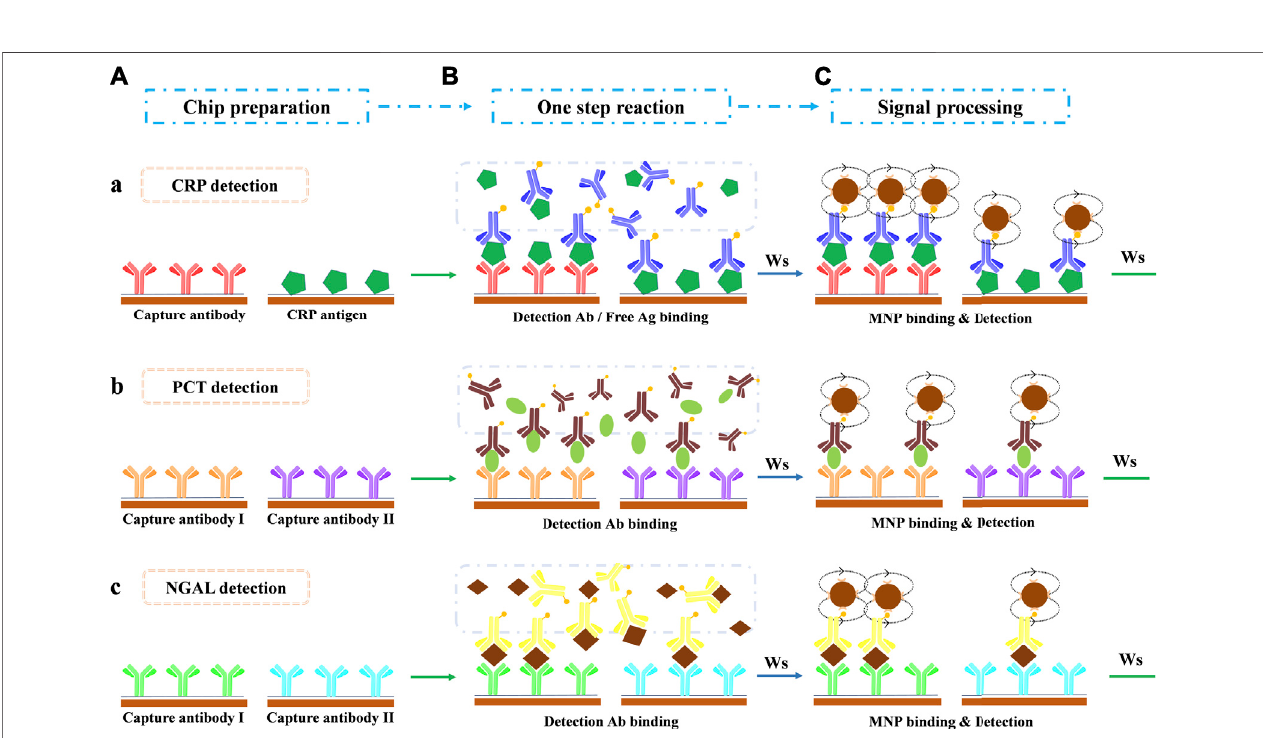
FIGURE2| Assayprotocolformulti-biomarkerdetectioninaone-shotchip. (A) Chippreparation. (B) One-stepantibody-antigenreactionaftersampleloading. (C) Magneticparticlebindinganddetection.Ws:washingstep. (a) CRPdetection:thecombinationofsandwichassayandindirectcompetitiveassay. (b) PCTdetection:the combinationoftwosandwich assayswithtwoantibodypairsthatsharethesamedetectionantibody. (c) NGALdetection: thecombinationoftwosandwichassayswith two antibody pairs that share the same detection antibody.